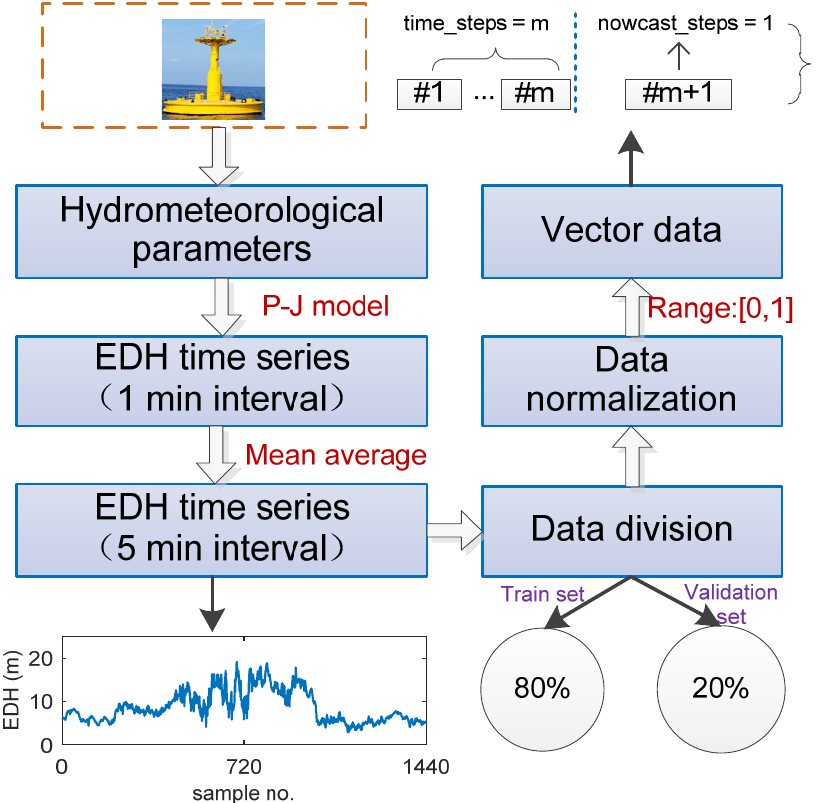
Figure 8. EDH data processing flow-chart.